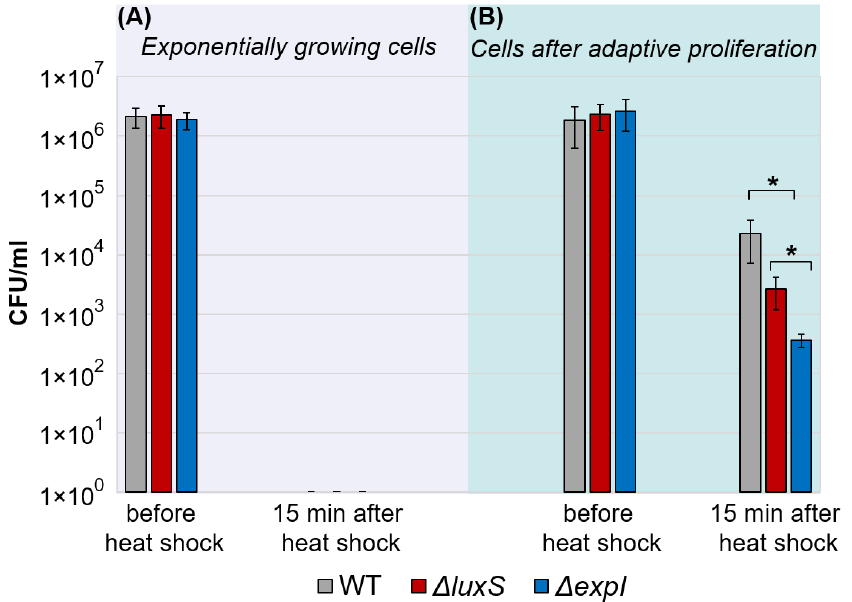
Figure 3. Heat shock resistance of the wild type Pectobacterium atrosepticum (WT, grey column) and its Δ expI (blue column ) and Δ luxS (red column) mutants. Cells sustained under two culture conditions were assayed: ( A ) cells grown in LB medium until the late log phase and ( B ) cells that passed through adaptive proliferation in a carbon-deficient medium. The duration of the heat shock was 5 min. Fifteen minutes after the heat shock was abolished, and the cell suspensions were plated to determine the CFU titer. The presented values are the means ± SD of three biological replicates. Asterisks (*) show a significant difference (Mann – Whitney two-sided test, p < 0.05) between the variants designated by brackets. variants designated by